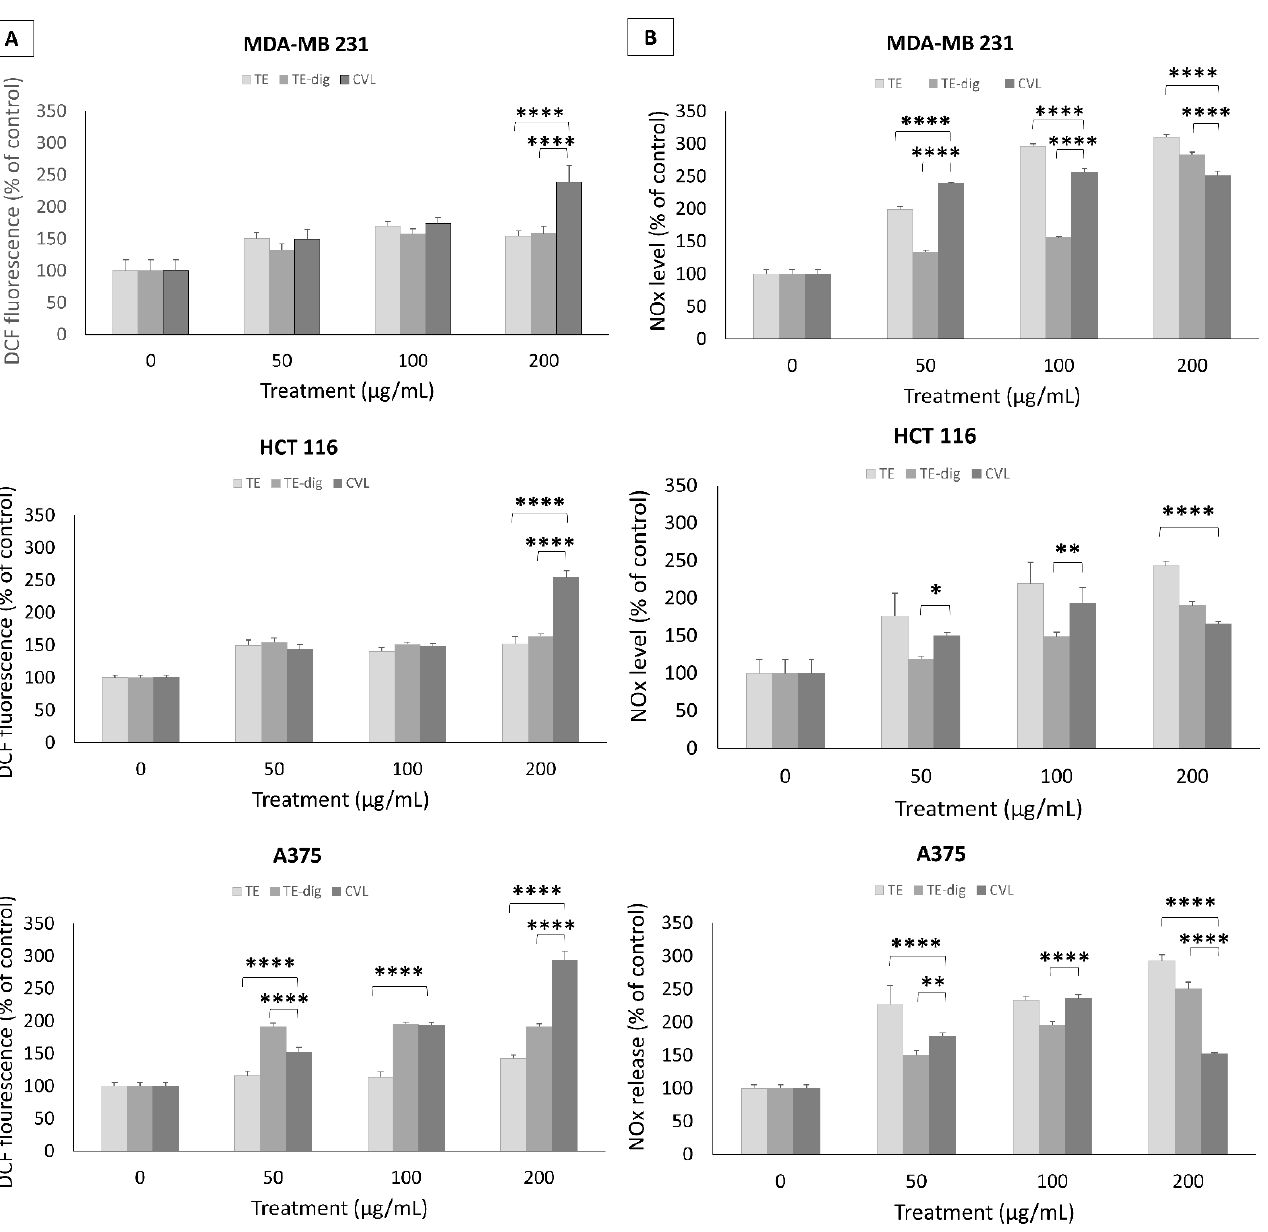
Figure 6. Pro-apoptotic effects of TE, TE-dig, and CVL on three cell lines: MDA-MB 231, HCT116, and A375, were assessed by measuring the ROS ( A ) and NO production ( B ) using spectrophotometric and fluorometric analyses, respectively. Values are expressed as % of control. Data represent the mean of five independent experiments. Statistical analysis for cell viability data was performed using two-way ANOVA followed by Tukey’s post-test (* p < 0.05, ** p < 0.01, **** p < 0.001). An opposite trend was observed in terms of NO release. In this case, the extracts, at the highest concentration (200 µ g/mL), were stronger than carvacrol in triggering the NO release in MDA-MB231 (+283.% for TE-dig, +310.4% for TE, and +251.6% for CVL), as well as in HCT116 and A375 cells, where the release was maximum for TE (+242.7% and +292.6%, respectively) followed by TE-dig (+190.4% and +250.4%, respectively) and by CVL (+165.3% and +151.7%, respectively) in the three cell lines (Figure